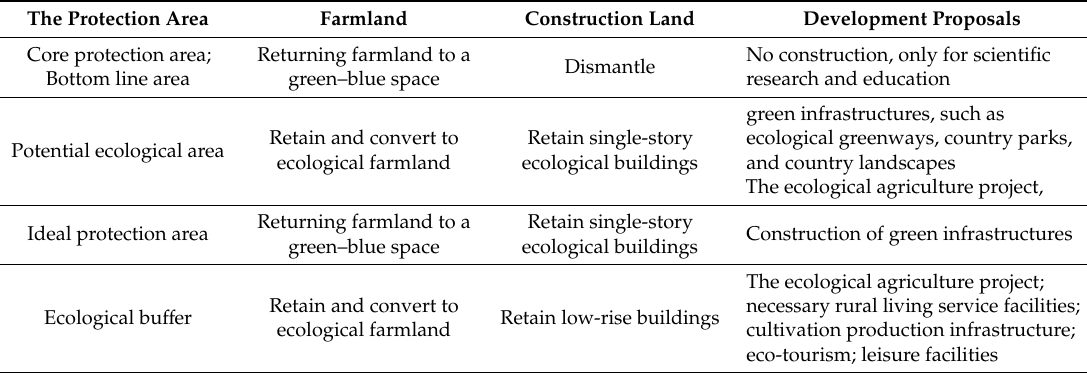
Table 8. Ecological conflict area control